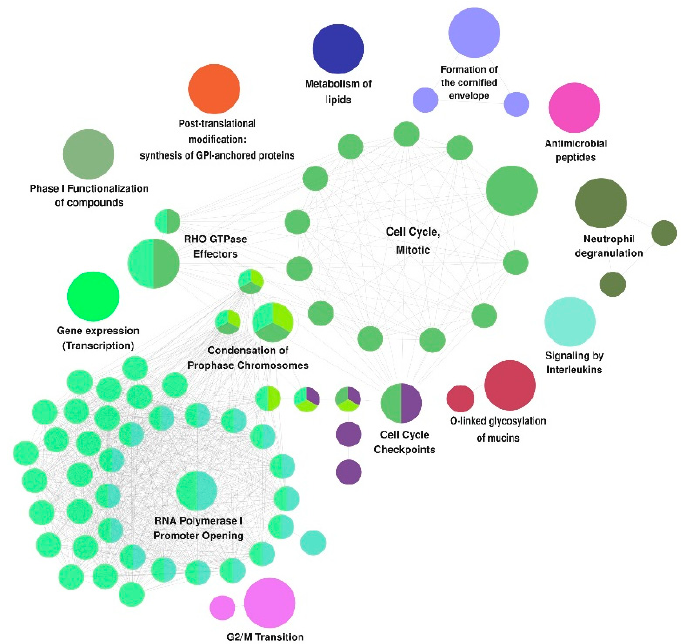
Figure 4. Summary of the Reactome categories and functional pathways enriched in trigonal urothe- lium (shown in Table S4). Big dots—category; small dots—pathways.